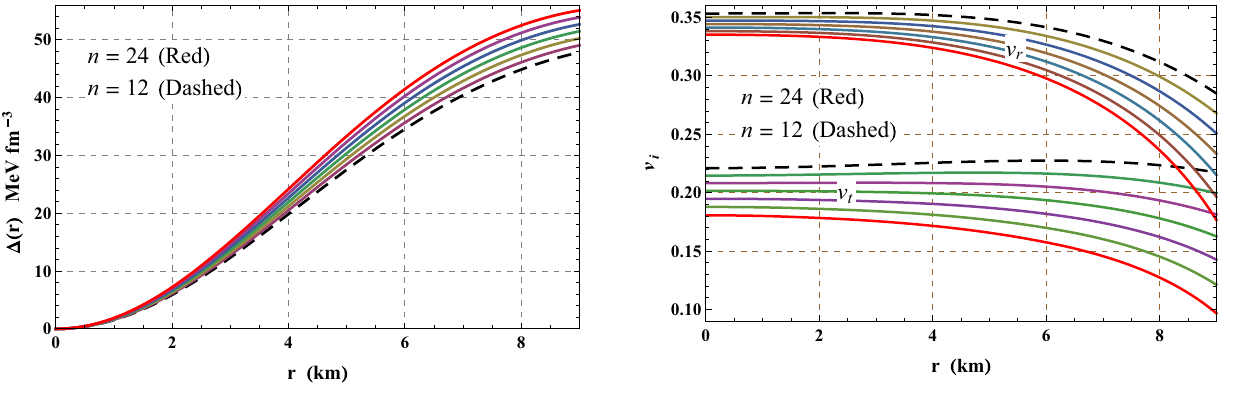
Fig. 4 Variationofanisotropywithradialcoordinatefortheparameters